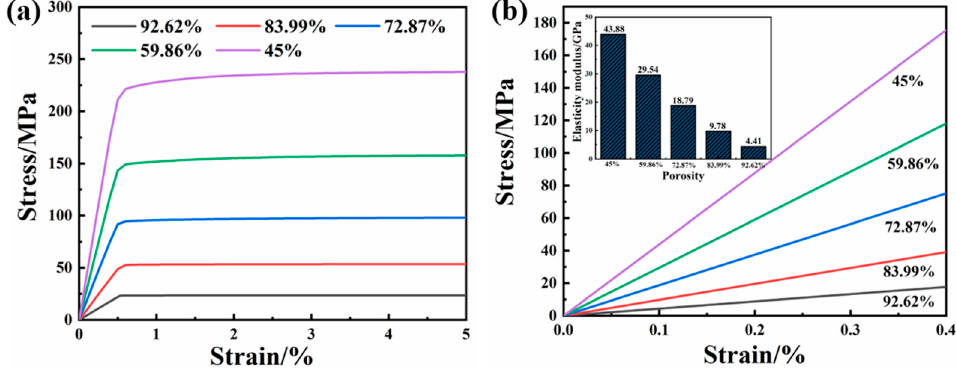
Figure 5. ( a ) Compressive stress–strain simulation curves of different structural columns. ( b ) The simulated elastic modulus of porous structures with different porosity gradients.